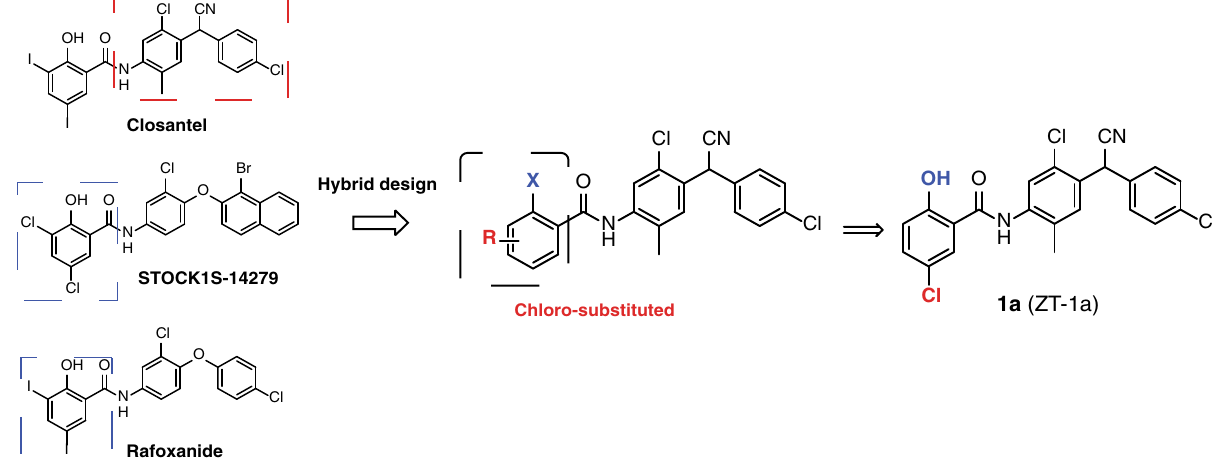
Fig. 1 Hybrid design strategy yields the novel SPAK – CCC modulator ZT-1a. Development of a new SPAK inhibitor (ZT-1a) through the combination of pharmacophores of the 2-(4-amino-2-chloro-5-methylphenyl)-2-(4-chlorophenyl)acetonitrile moiety from Closantel and the chloro-substituted 2-hydroxybenzoic acid from STOCK1S-14279 and